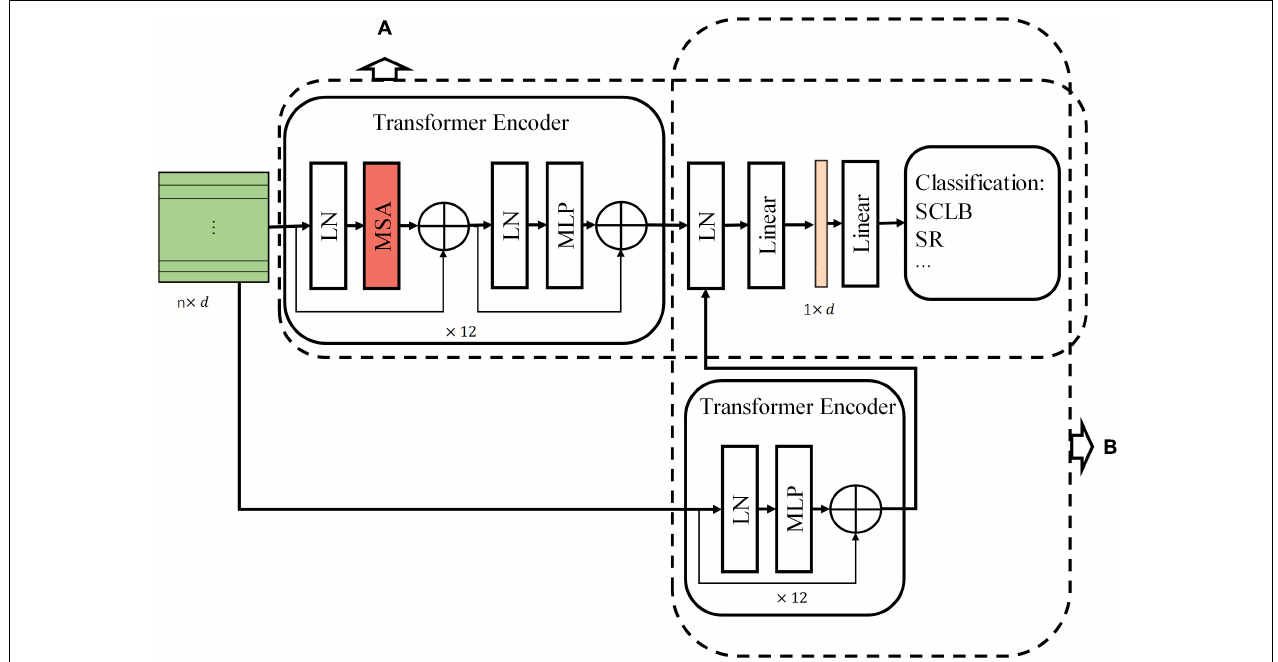
FIGURE 5 | Two models changed from the standard model. (A) Model-1. (B) Model-2.